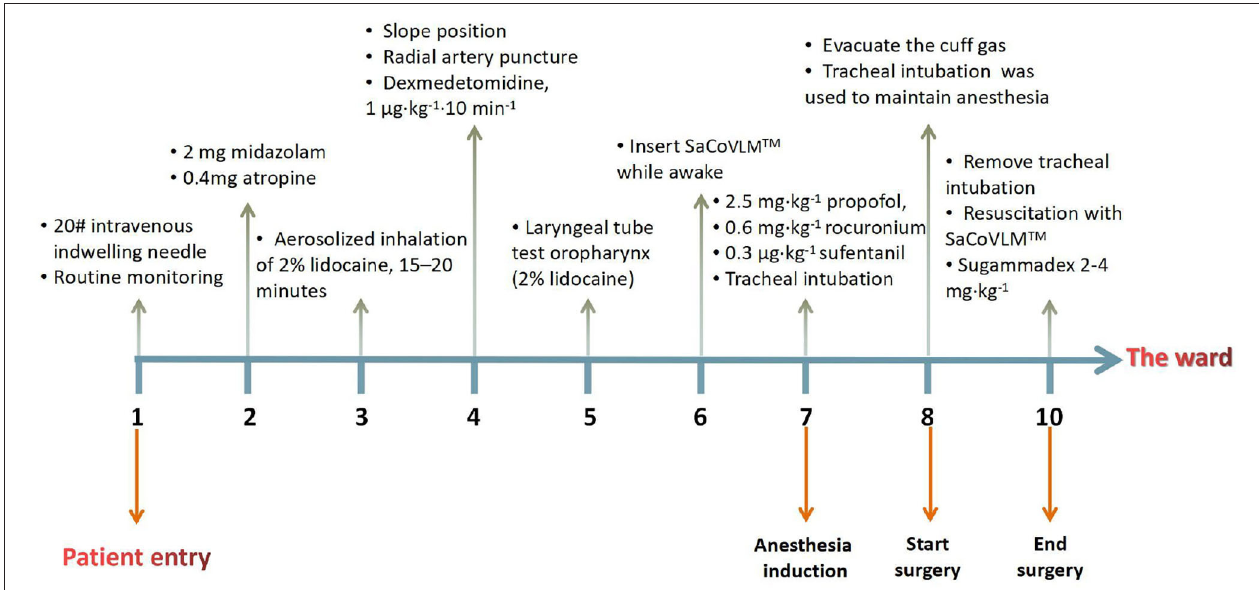
FIGURE 3 | Anesthesia management